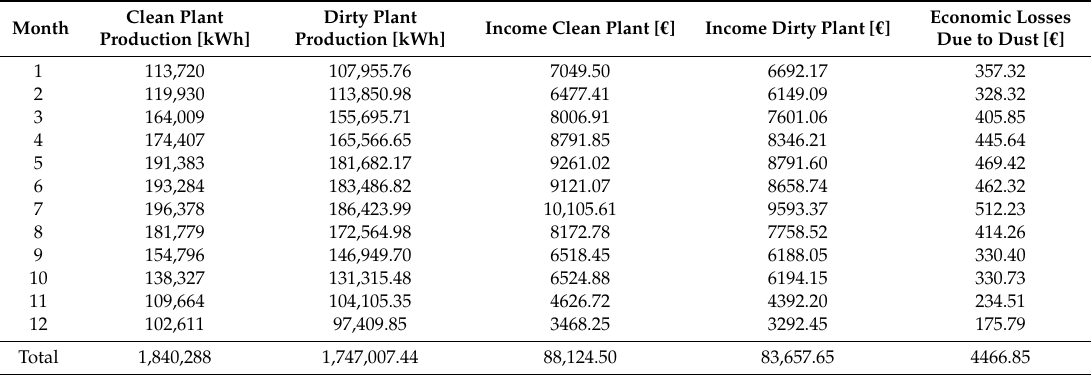
Table 7. Income from the clean and dirty 1 MWp